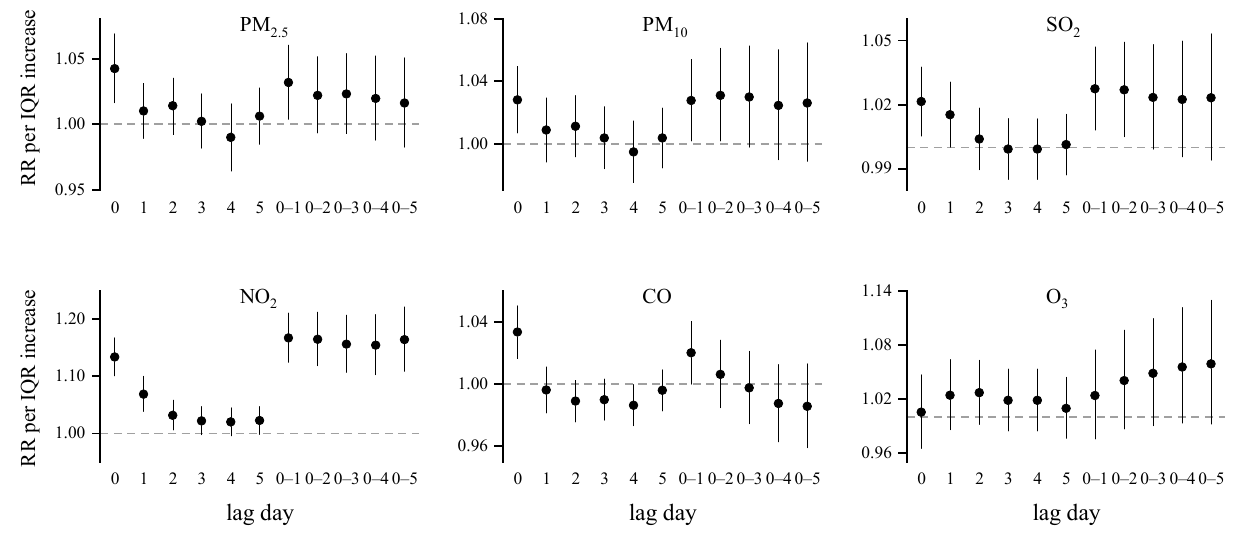
Figure 2. Relative risks (RRs) of outpatient visits for AR associated with an IQR increase in the air pollutants at different lag days during 2014–2020. IQR: PM 2.5 , 55 µ g/m 3 ; PM 10 , 70 µ g/m 3 ; SO 2 : 7 µ g/m 3 ; NO 2 : 27 µ g/m 3 ; CO: 0.5 mg/m 3 ; O 3 : 86 µ g/m 3 . Table 2. Relative risks (RRs) of outpatient visits for allergic rhinitis associated with an IQR increase in the air pollutants for different seasons a .